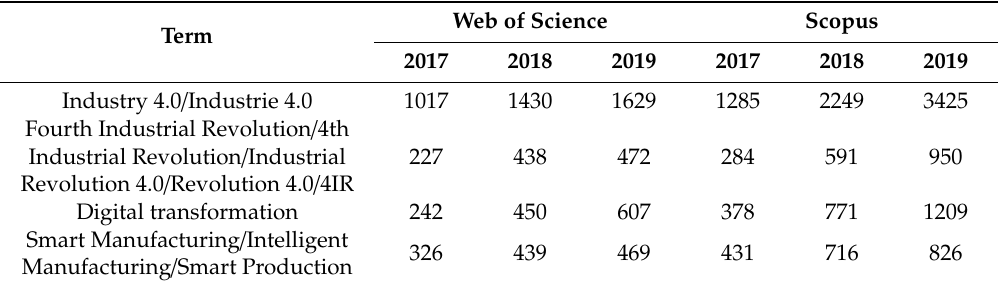
Table 1. Frequency of use of the term “Industry 4.0” and related terms in publications issued in 2017–2019 in Web of Science and Scopus